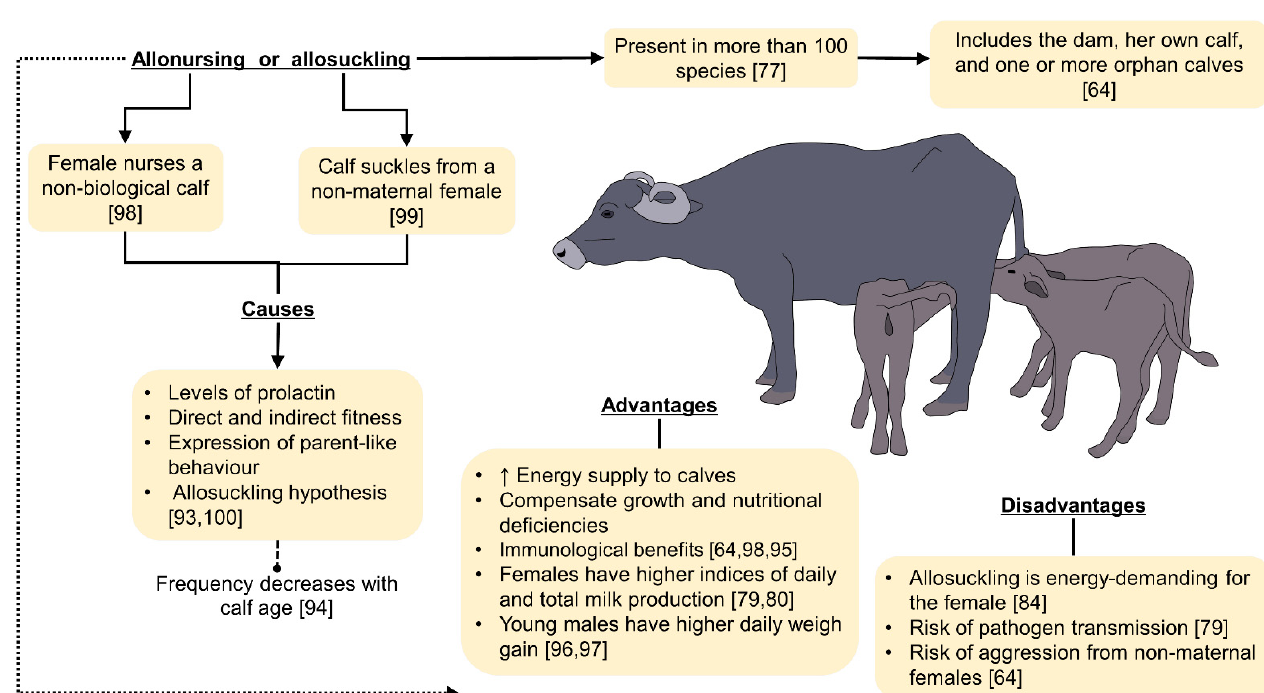
Figure 2. Allonursing and allosuckling causes, disadvantages and advantages to the mother and the offspring. While allonursing and allosuckling respond to endocrine and social contexts, they involve difficulties to the mother, such as the high energy demand, and to the young because of the risk of aggression of the foster mother, and the risk of pathogen transmission to the calves. However, some benefits include the compensation of nutritional deficiencies in the calves, and the acquisition of a wider range of immunoglobulins to enhance the immune system, as well as an enhancement in productivity parameters, such as daily weight gain.